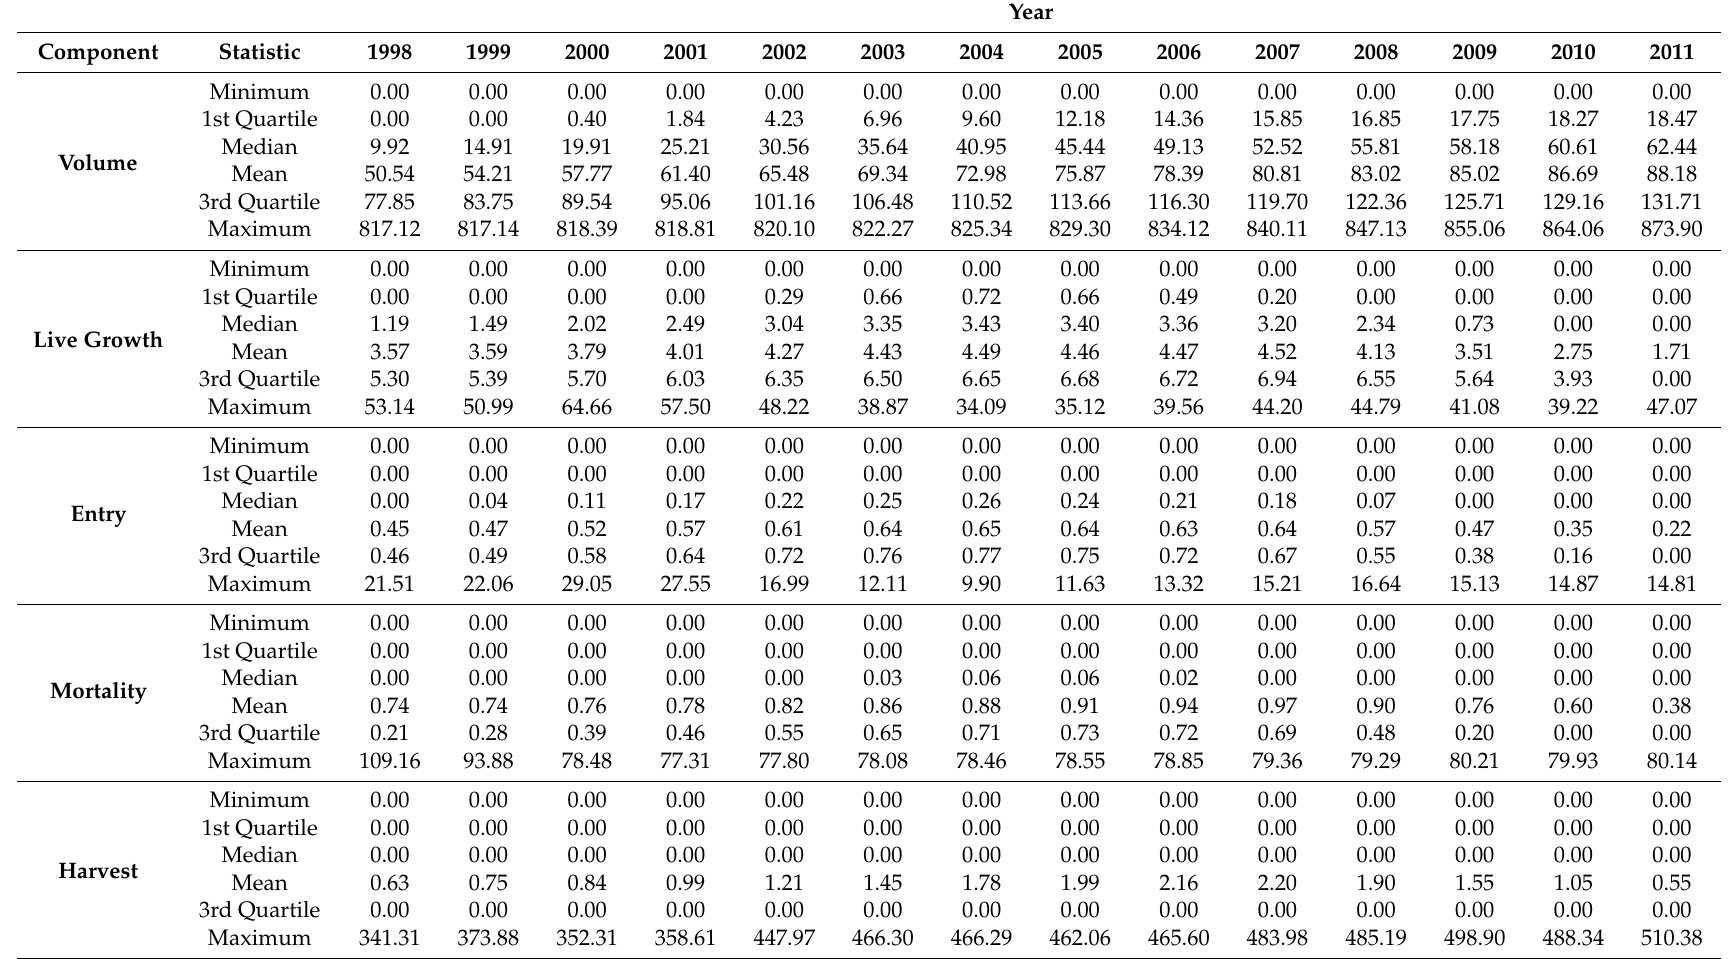
Table A2. Distribution statistics for population